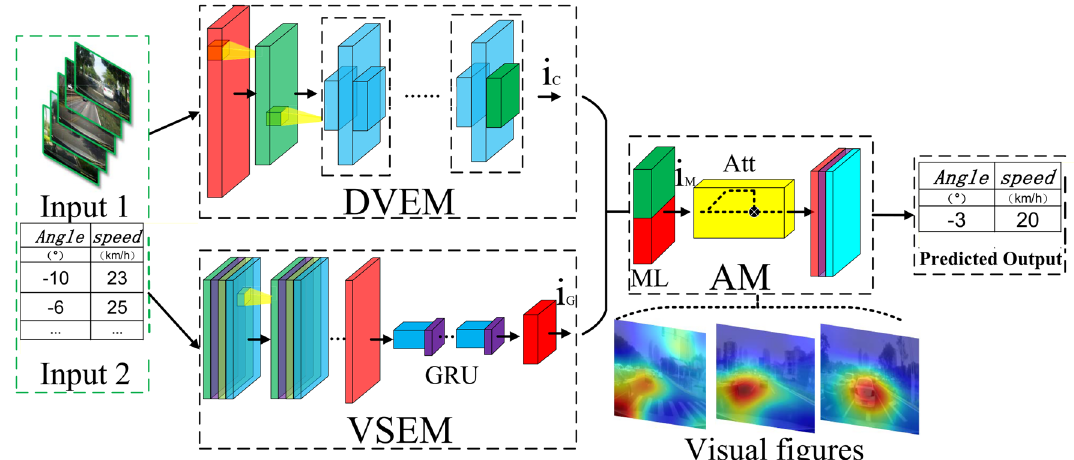
Figure 2. The structure diagram of the driver’s attention imaging